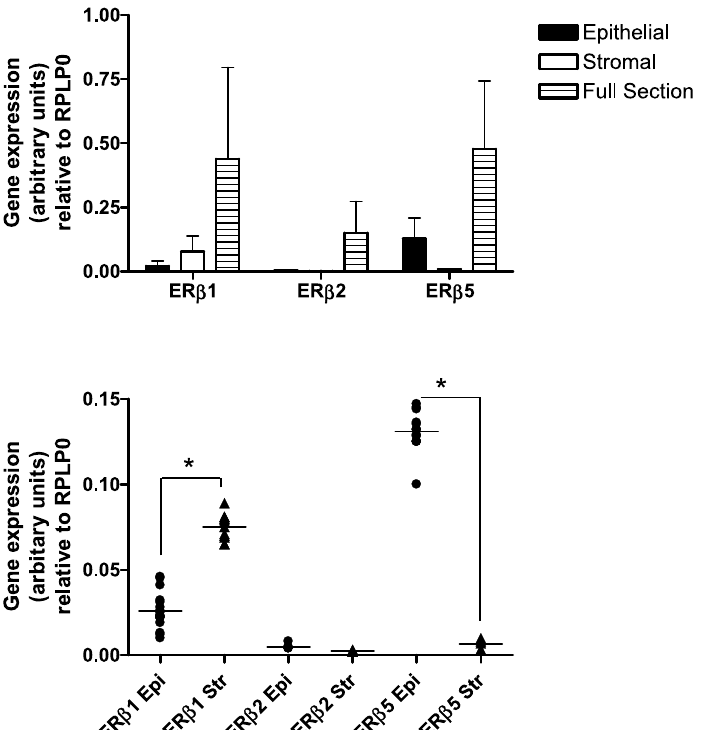
Fig. 2. qRT-PCR expression of ER β 1, -2 and -5 in whole sections and epithelial and stromal cells microdissected from breast cancer cell lines and fibroblasts (a). Mean data for epithelial and stromal components is re-plotted in (b) and shows significantly more ER β 1 and ER β 5 in the stromal and epithelial compartments, respectively. ∗ P < 0 . 05, ∗∗ P < 0 . 01. Data is presented as mean values ± SD from 25 individual breast